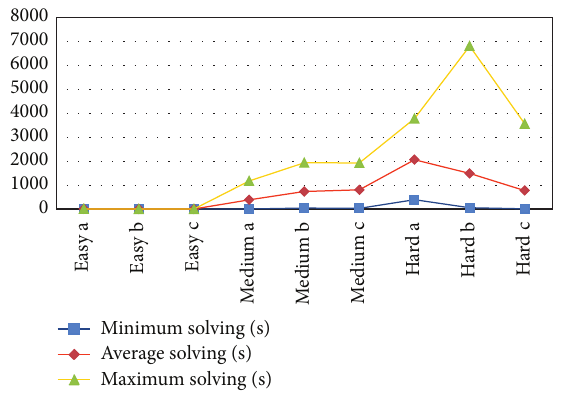
Figure 6: Comparing solving times for